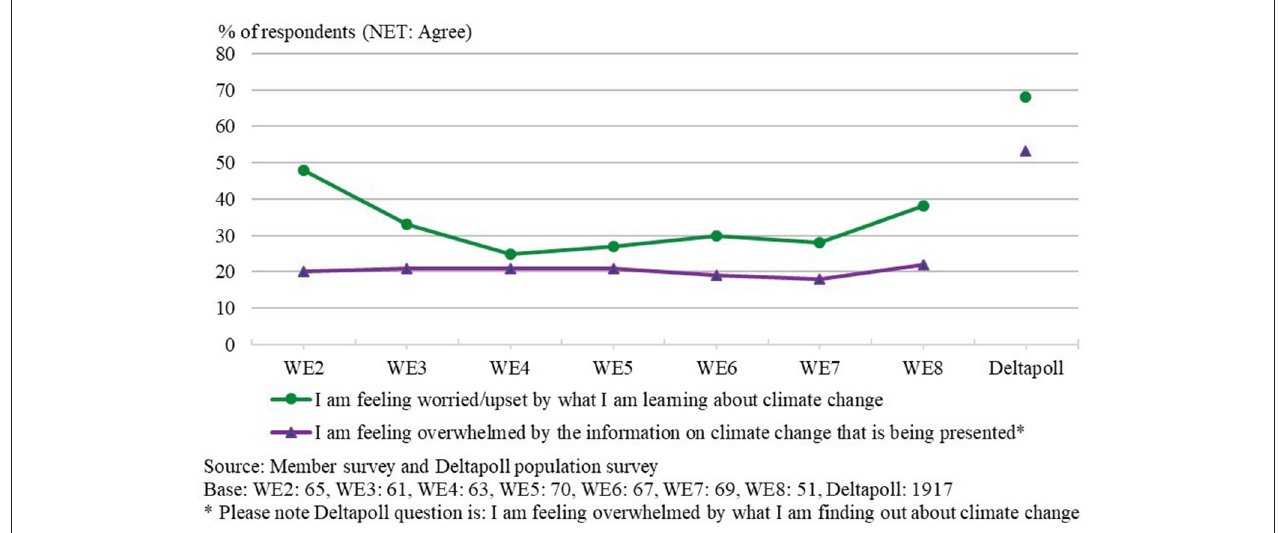
FIGURE 3 | Assembly members and public worry upset and overwhelm about climate